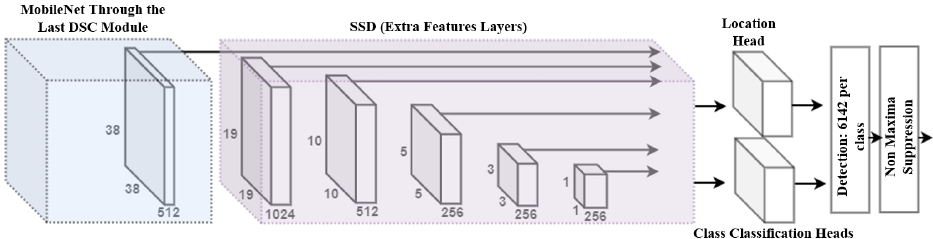
Figure 5. The visual overview of the MobileNet SSD architecture employed in our proposed